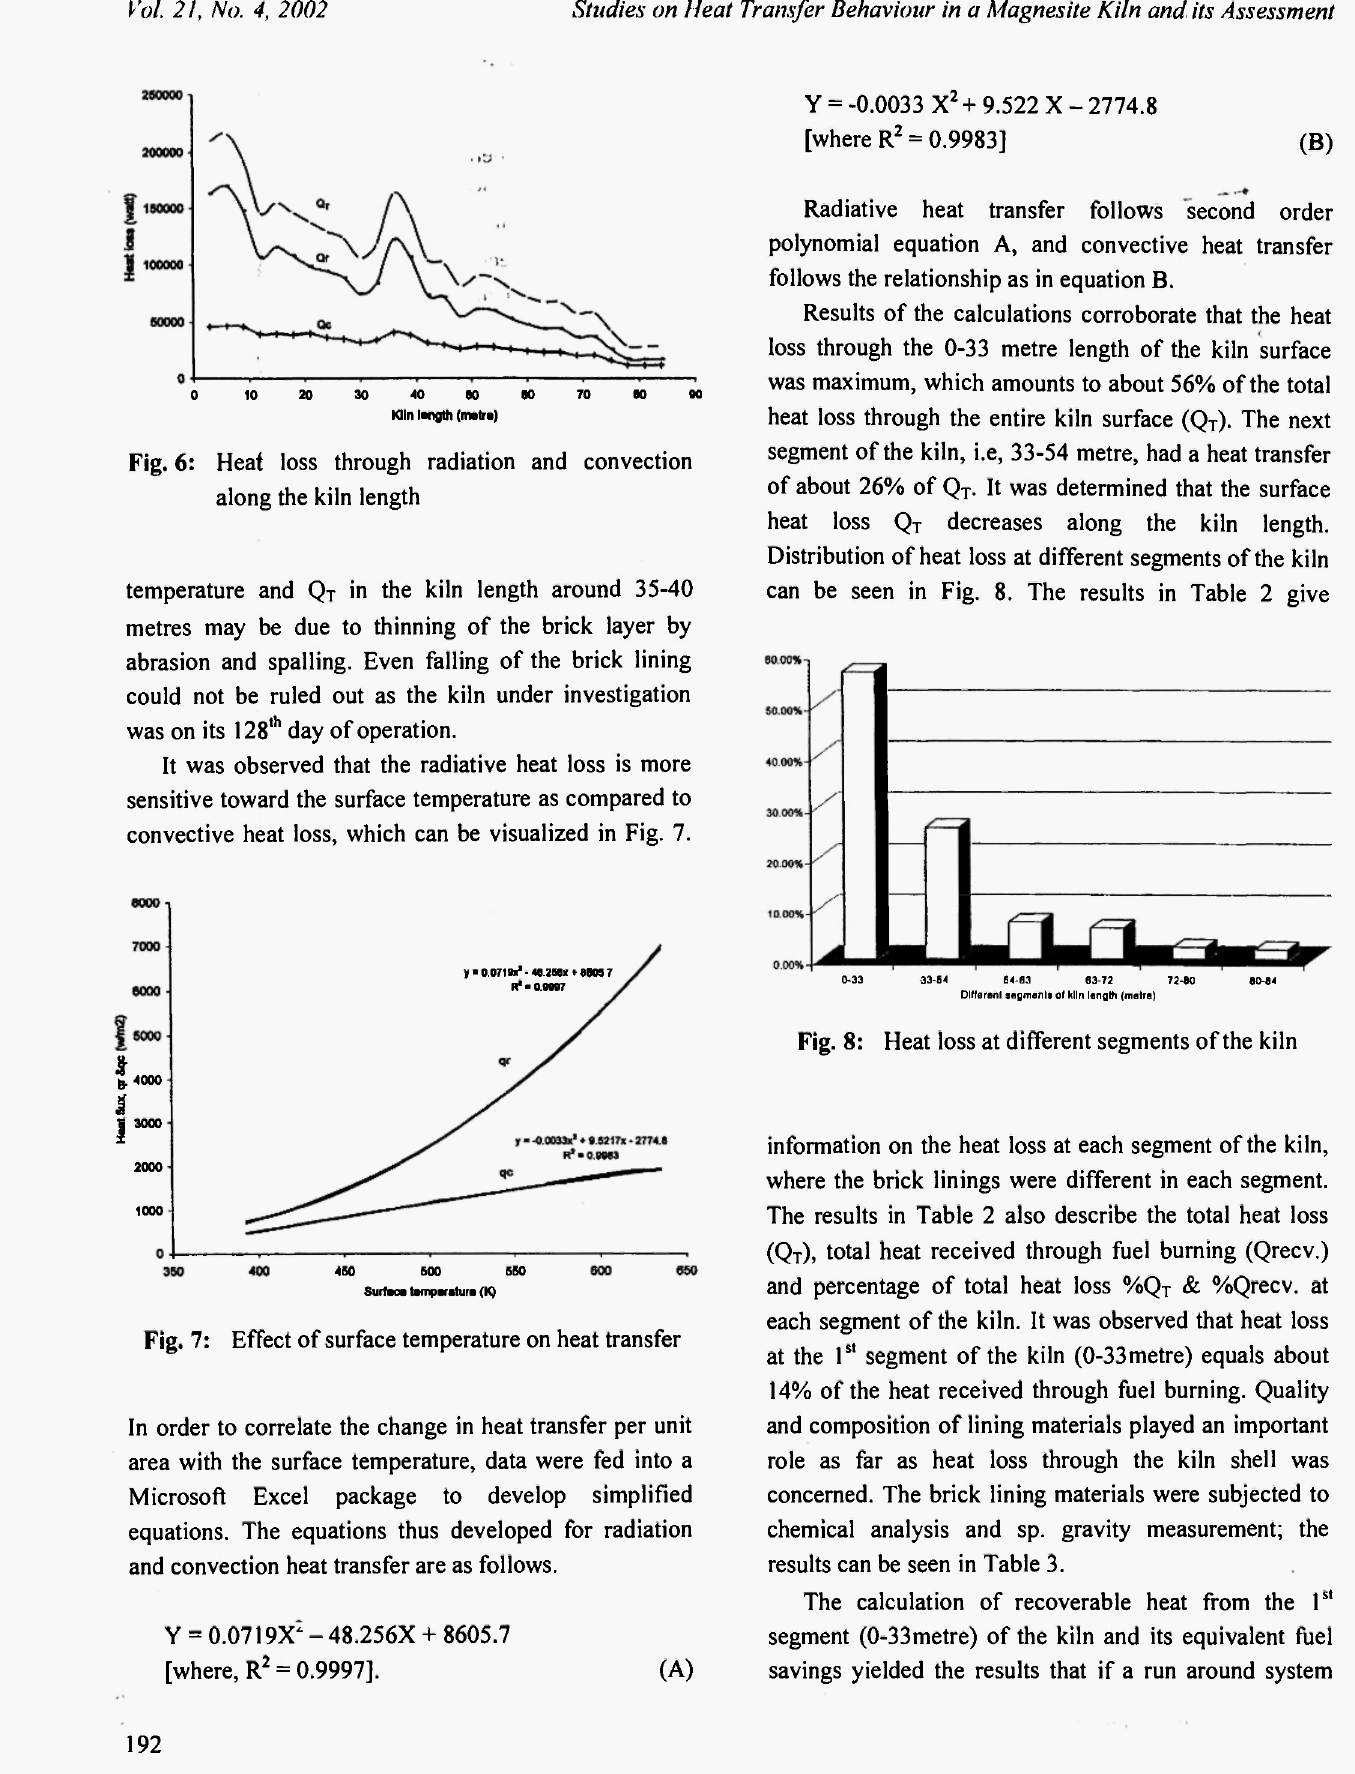
In order to correlate the change in heat transfer per unit area with the surface temperature, data were fed into a Microsoft equations. The equations thus developed for radiation and convection heat transfer are as follows.